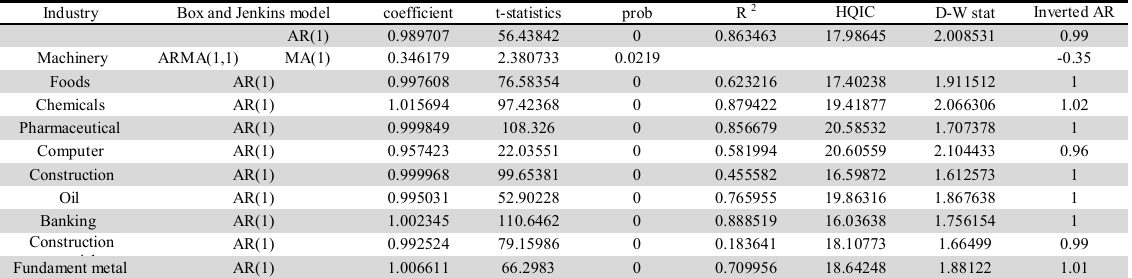
Stock price panels model identification results